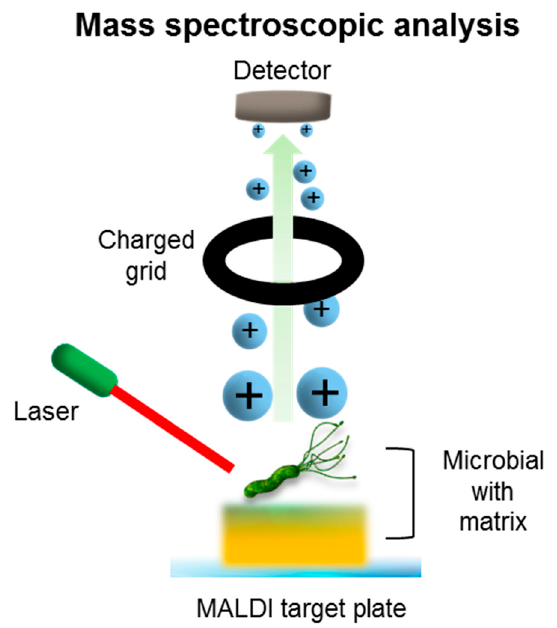
Figure 8. Schematic illustration of mass spectroscopic method (e.g., Matrix-assisted laser desorption/ionization time-of-flight (MALDI-TOF)) performed via laser-driven ionization of the target sample followed by time-of-flight analysis of peptide fragments for the identification of a specific